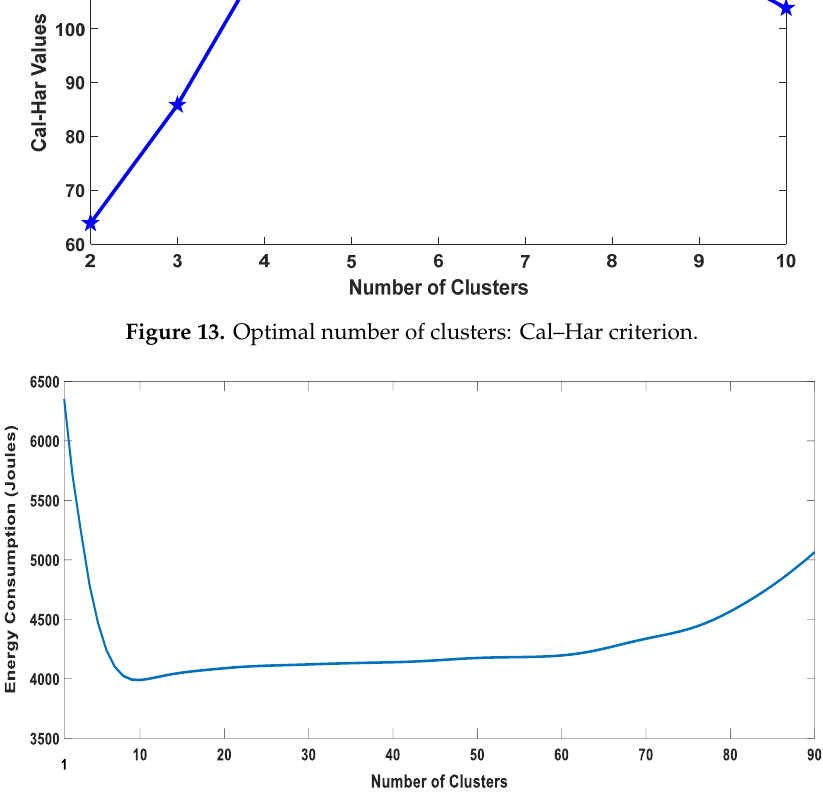
Figure 14. Energy consumption and the number of clusters: a comparison.